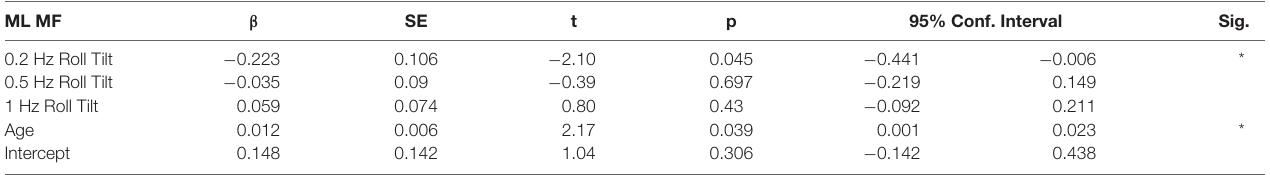
TABLE 4 | Results of a multivariable linear regression model. ML MF β SE t p 95% Conf. Interval